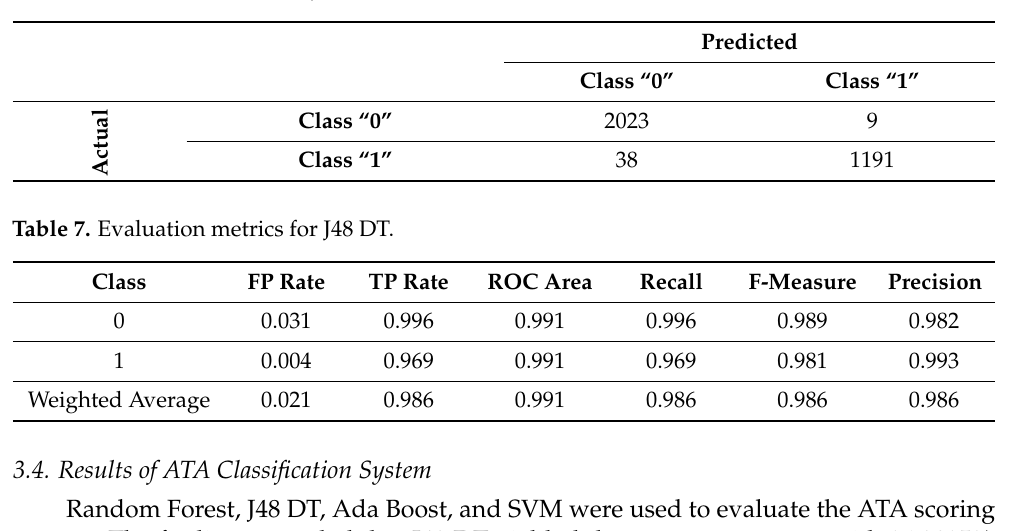
Table 6. Confusion matrix for J48 DT.